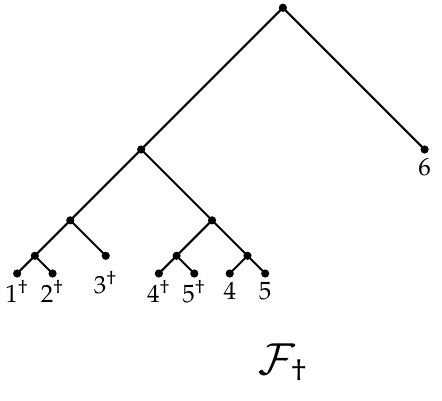
Figure 3. (cid:101) U − 1 is the fixator of the tree F † .